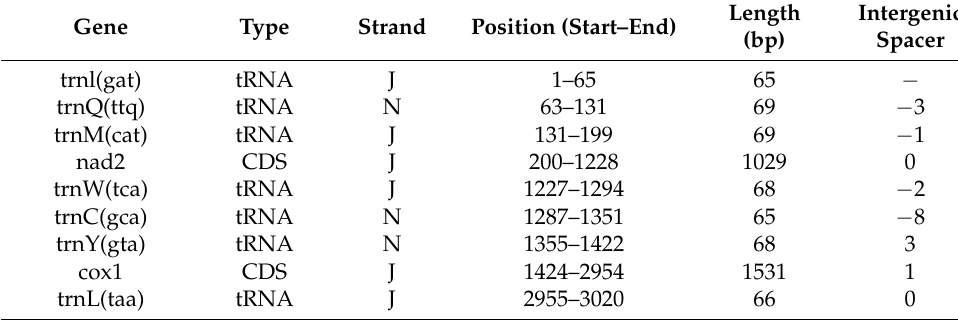
Table 2. Gene order and basic characteristics of the P. casei mt